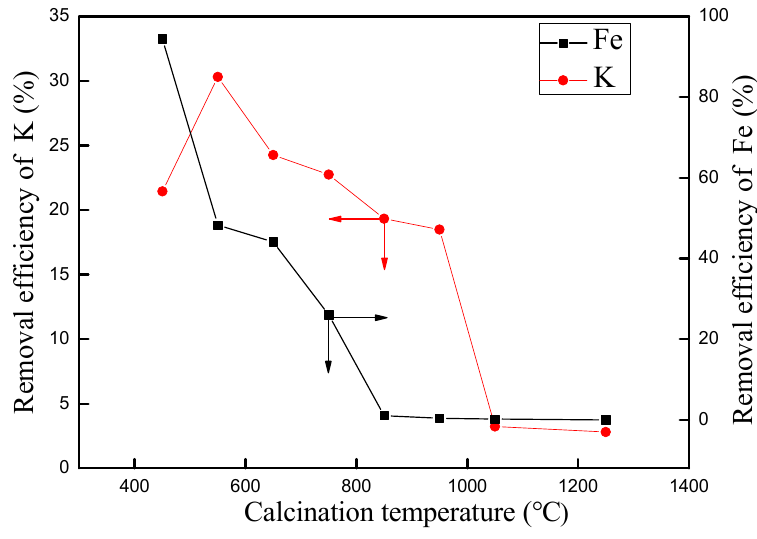
Figure 6. Effect of calcination temperatures on the removal efficiency.